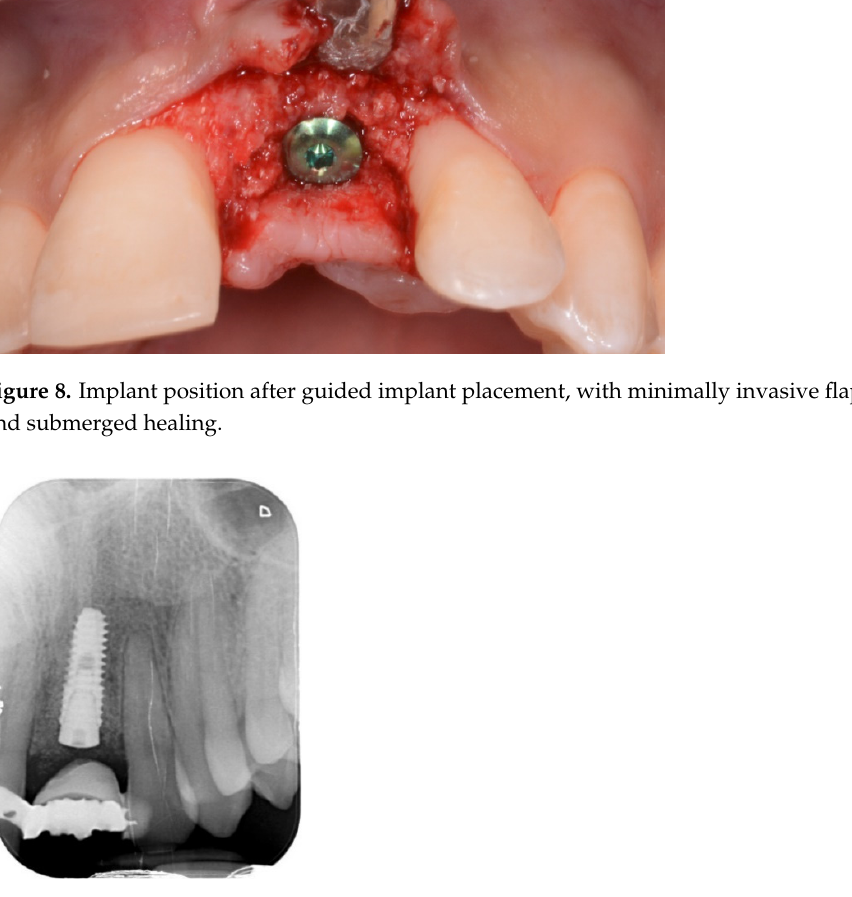
Figure 9. Periapical radiograph after guided implant placement.